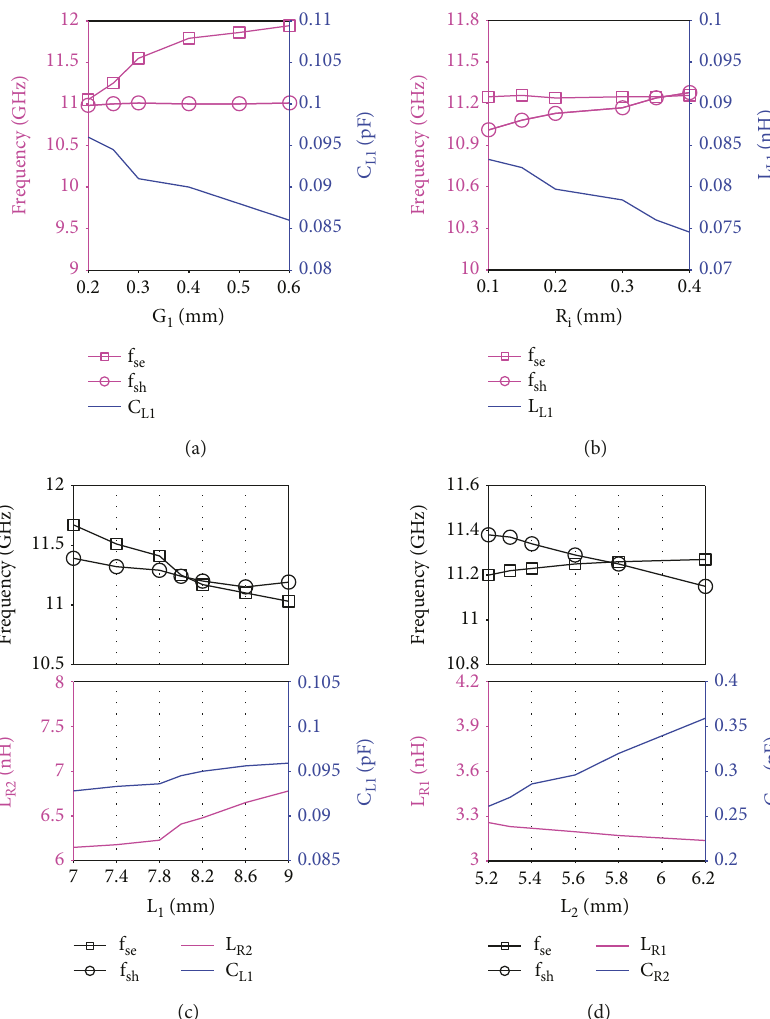
, the width of the transverse slots; (b) R 1